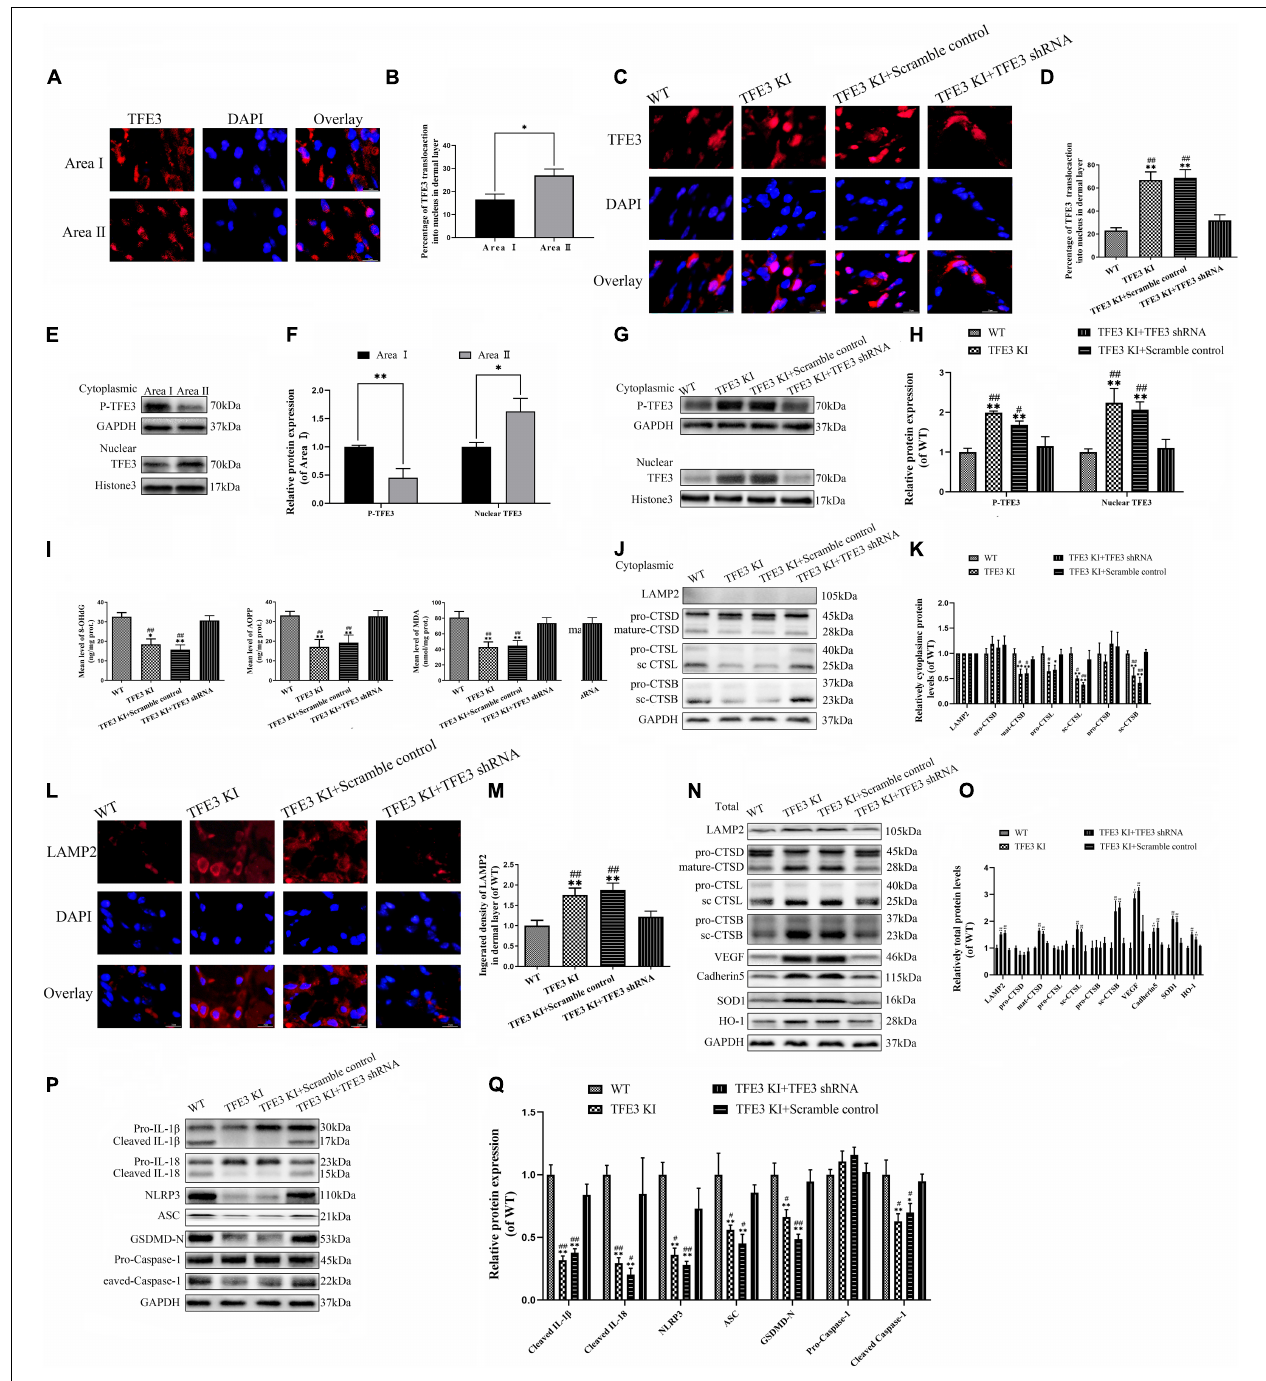
FIGURE 5 | TFE3 ameliorates ROS-induced lysosomal malfunction and downregulates pyroptosis in random skin flaps. (A,E) Immunofluorescence exhibiting the nuclear translocation of TFE3 (red) (scale bar: 25 mm). (B,F) Percentage of TFE3-positive cells. (C,G) Western blot exhibited cytoplasmic TFE3 and nuclear TFE3. (D,H) Quantification of cytoplasmic and nuclear TFE3 proteins immunoblots. (I) ELISA of 8-OHdG, AOPP, and MDA in flap tissue from WT, TFE3 KI, TFE3 KI + scramble and TFE3 KI + TFE3 shRNA groups. (J,N) Western blotting of the lysosome function-related proteins CTSD, LAMP2, CTSB, and CTSL in total protein and cytoplasmic protein. (K,O) Densitometric analysis of CTSD, LAMP2, CTSB, and CTSL. (L) Immunofluorescence for LAMP2 in skin flaps (scale bar: 25 mm). (M) The fluorescence intensity for LAMP2. (N) Western blotting of VEGF, cadheirn-5, SOD1, and HO-1 in flap tissue from WT, TFE3 KI, and TFE3 KI + scramble and TFE3 KI + TFE3 shRNA groups. (O) Densitometric analysis of VEGF, cadherin-5, SOD1, and HO-1. (P) Western blotting of the pyroptosis related proteins. (Q) Quantification of pyroptosis related proteins immunoblots. Values are shown as the mean ± SEM, n = 6 per group. * p < 0.05 and ** p < 0.01, vs. WT group or area I group. # p < 0.05 and ## p < 0.01, vs. TFE3 KI + TFE3 shRNA